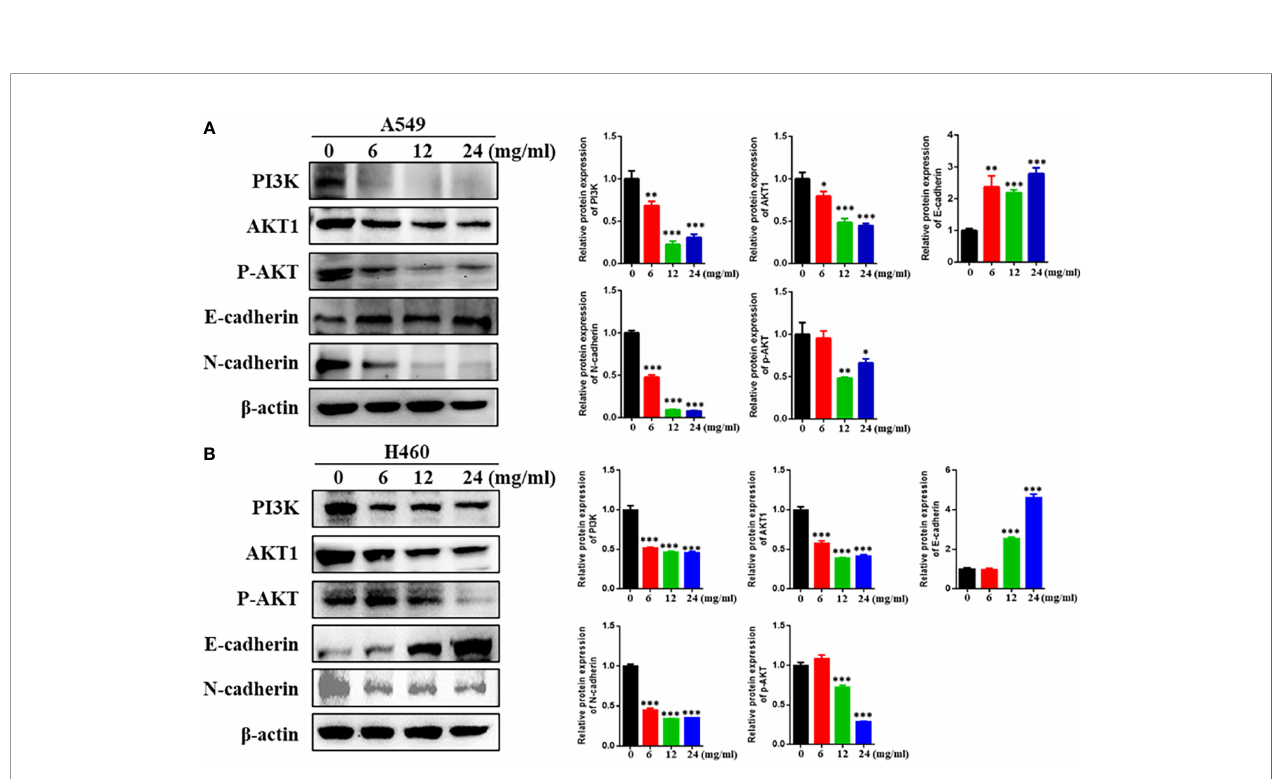
FIGURE 9 | HMMCR suppresses NSCLC cells progression via targeting PI3K/Akt pathway. PI3K, AKT1, p-AKT, E-cadherin, and N-cadherin expressions in (A) A549 and (B) H460 cells after HMMCR treatment at the doses of 0 – 24 mg/ml for 48 h were determined by Western blot assay. b -Actin was used as an internal control. All data were quanti fi ed by Image J software. *p < 0.05, **p < 0.01, ***p < 0.001 vs.